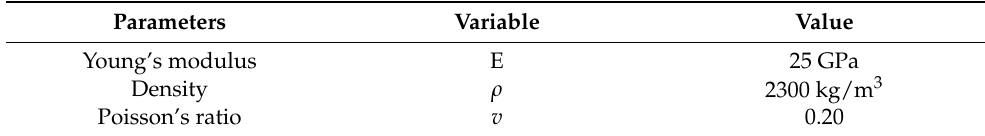
( b ) Figure 7. Concrete cube with embedded PZT sensor: ( a ) The schematic one-fourth model; ( b ) Two- axis symmetry 3D model.